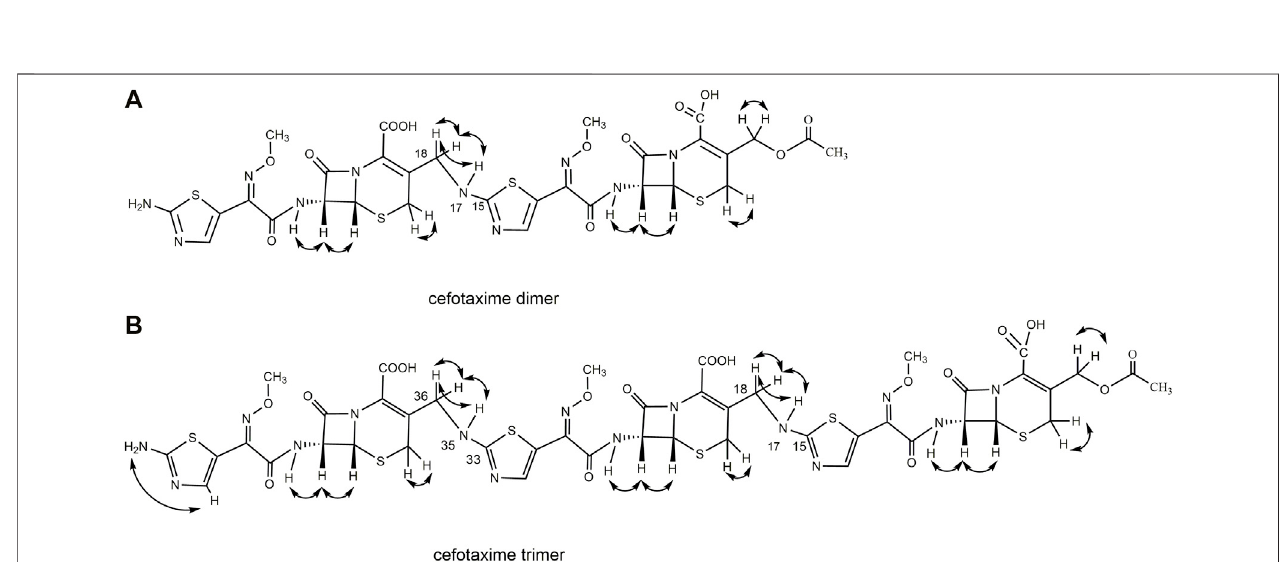
FIGURE 6 | The scheme of 1 H – 1 H COSY correlation ship of cefotaxime dimer and trimer.